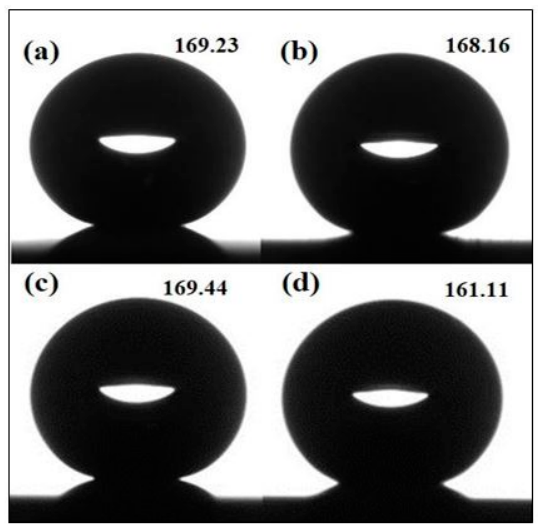
Figure 7. Water contact angles as a result of the abrasion against a 5000 grit sand paper with 7.75 kPa normal load. The inset SEM image (upper right) shows surface morphology after reaching 800 cm of abrasion length.